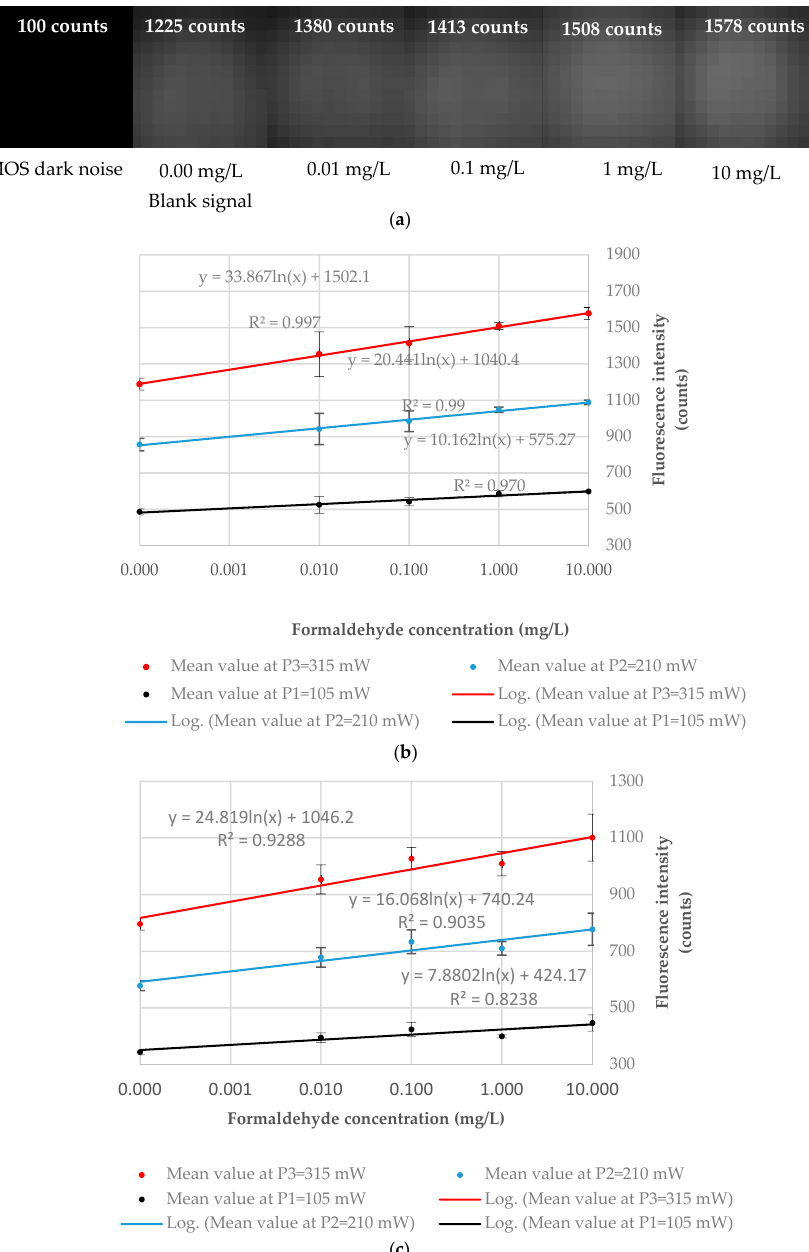
Figure 8. Experimental evaluation of the CMOS-based fluorescence detector realized using the mean values ( X ) of seven measurements ( n = 7 ) made on two independently prepared samples ( N = 2 ) at each of the c i , i = 0, ... , 4 concentrations tested. ( a ) ULS 24 CMOS image sensor 12 × 12-pixel output for the dark current, blank signal, and the four formaldehyde concentrations tested for a quartz cell at P = 315 mW. ( b ) Logarithmic fitting of the experimental points for a quartz fluidic cell. ( c ) Logarithmic fitting of the experimental points for a silicon fluidic cell. The error bars indicate one standard deviation ( N = 2